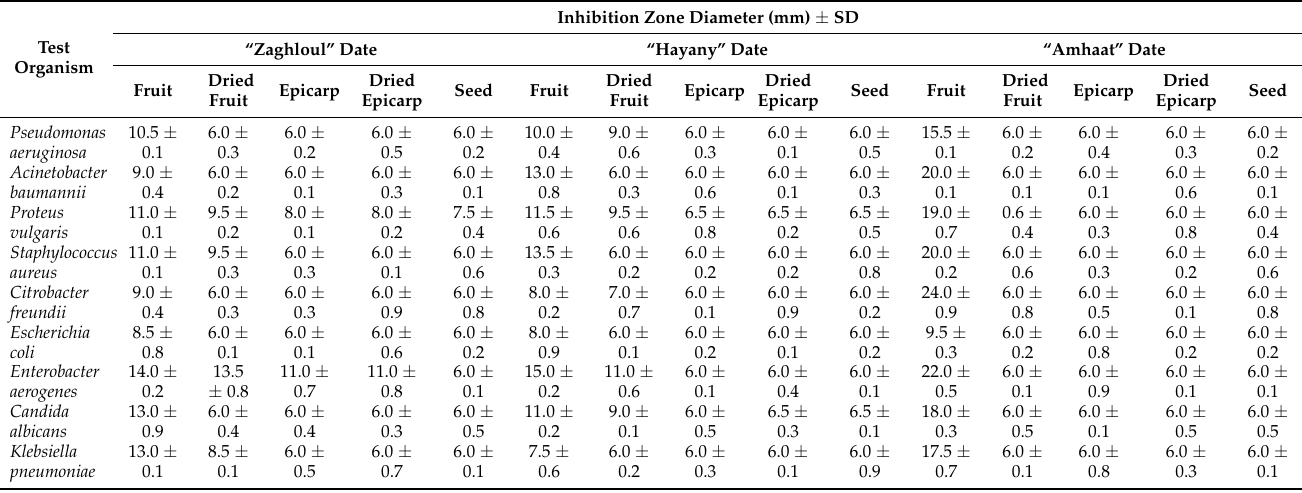
Table 1. Antimicrobial effects of Egyptian date extracts against some pathogens.